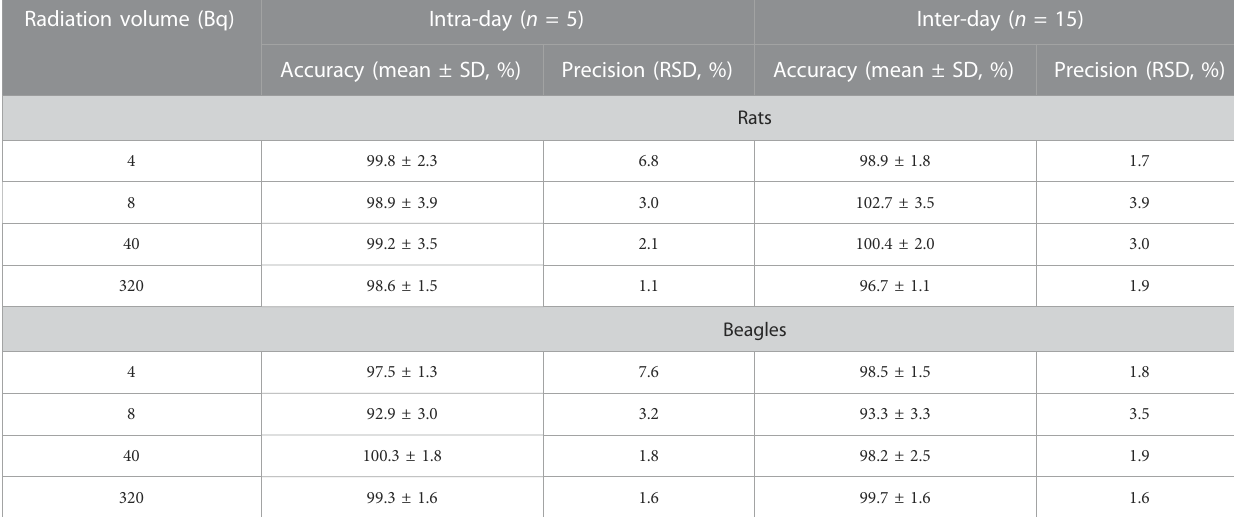
TABLE 1 Precision and accuracy results for the radioactivity determination of 3 H-SEP in rat and beagle plasma. Radiation volume